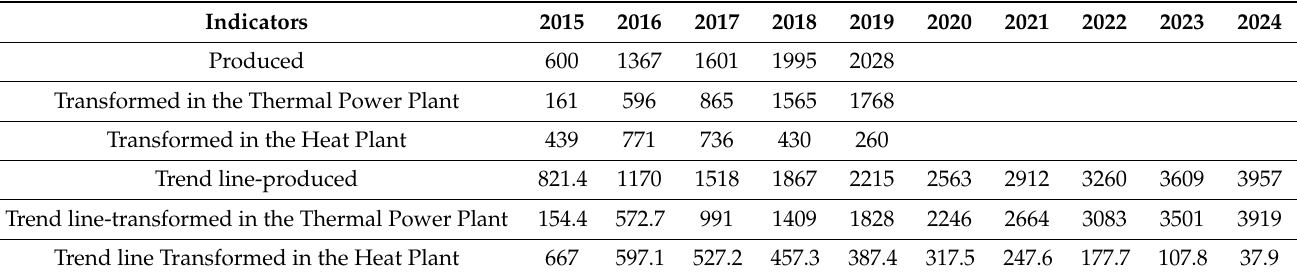
Table 5. Biogas production and conversion and development forecast, (units-GJ).